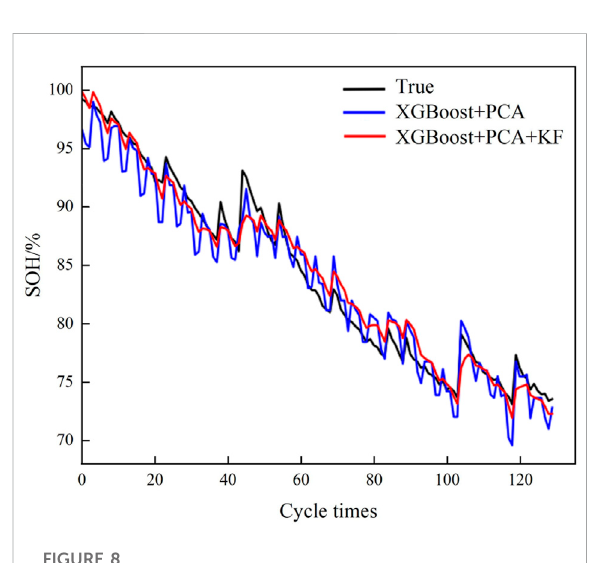
FIGURE 8 XGB-AKF model to estimate SOH results for Li-ion cells.